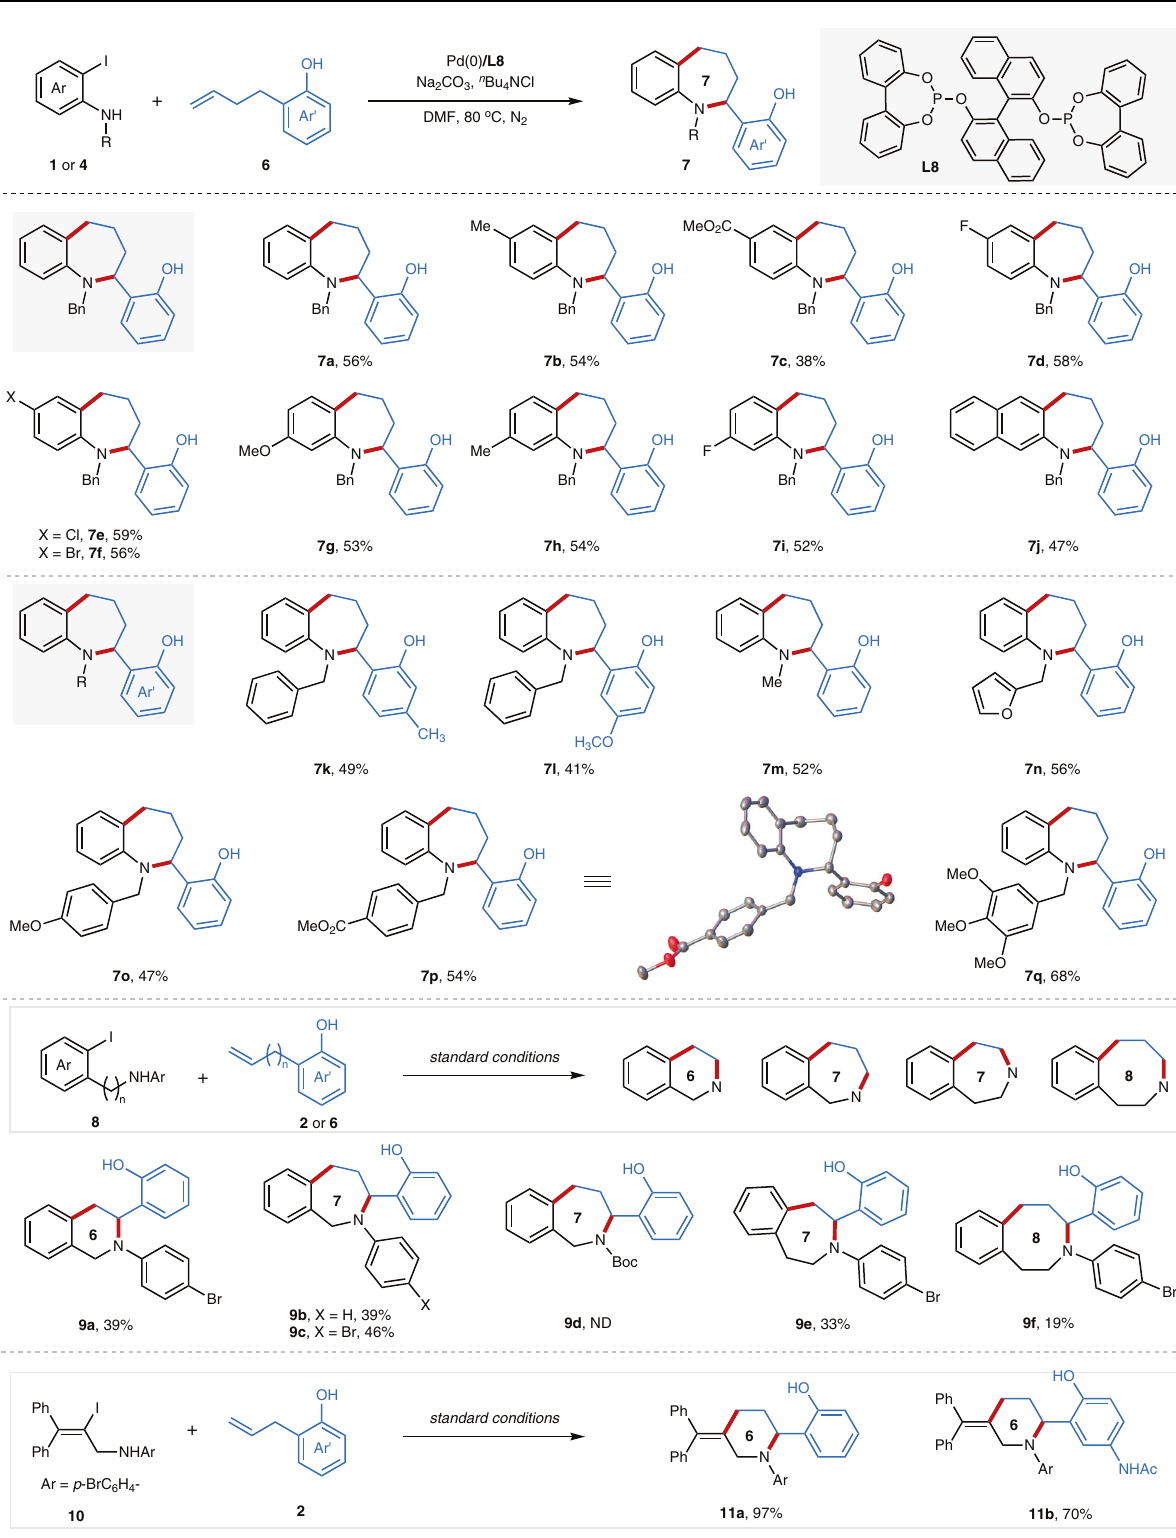
2.0 equiv.), DMF (3.0mL), 80°C,18h. For 7f , 7m and 7n the reactions were con- ducted for 36h. For 9a , 9b and 9c , the reactions were conducted with Pd 2 (dba) 3 (4.6mg, 2.5mol%), L8 (7.2mg, 5.0mol%). Bn, benzyl; Me, methyl; Ph, phenyl; Ar, aryl; Ac, acetyl; Boc, t -butoxycarbonyl; DMF, N , N -dimethylformamide; ND, not